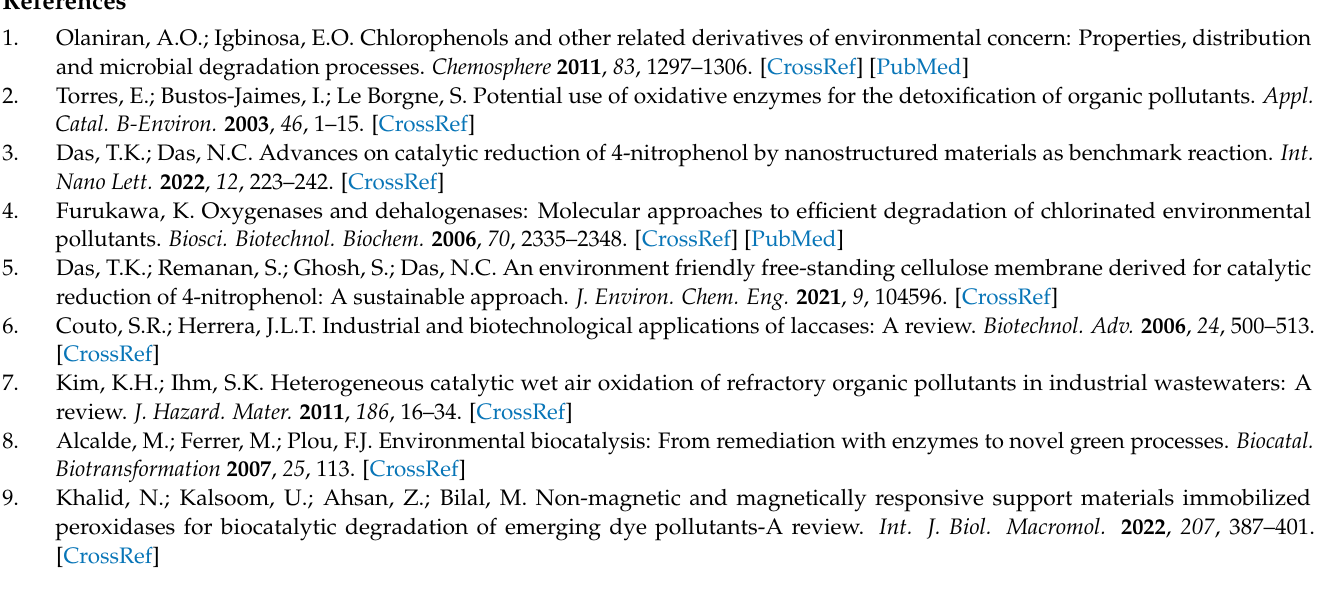
Figure S2: Effect of enzyme concentration on laccase immobilization; Figure S3: Effect of pH on laccase immobilization; Figure S4: Effect of temperature on laccase